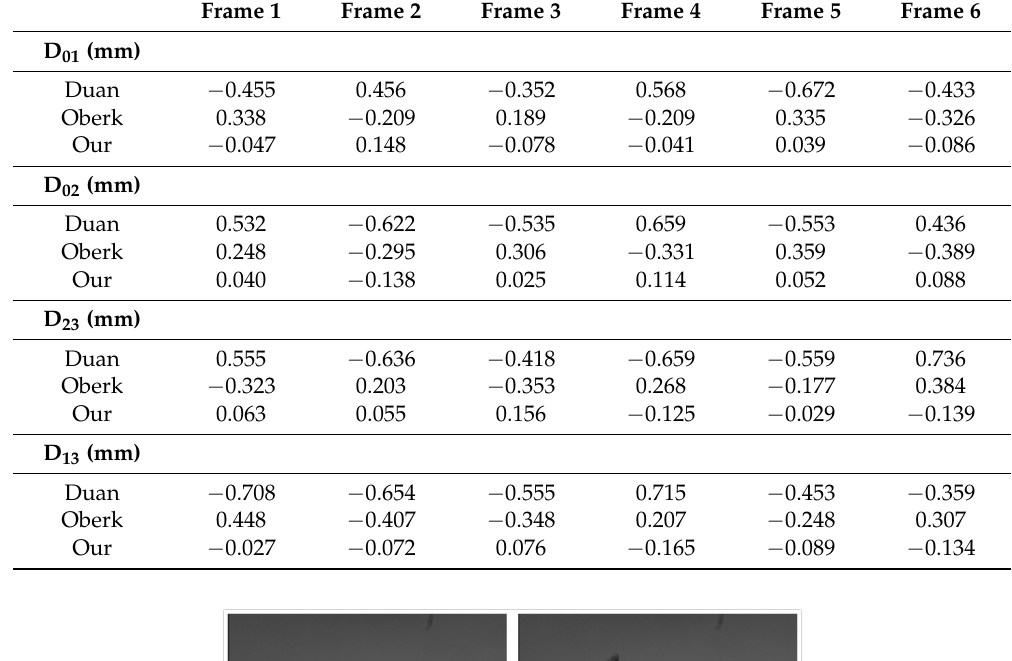
Table 2. The measurement errors of the calibration board.